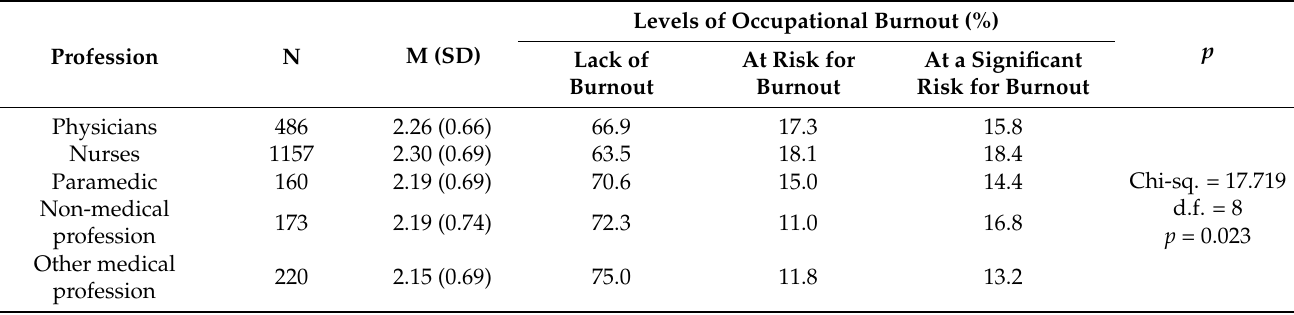
Table 2. Mean occupational burnout scores by profession (N =